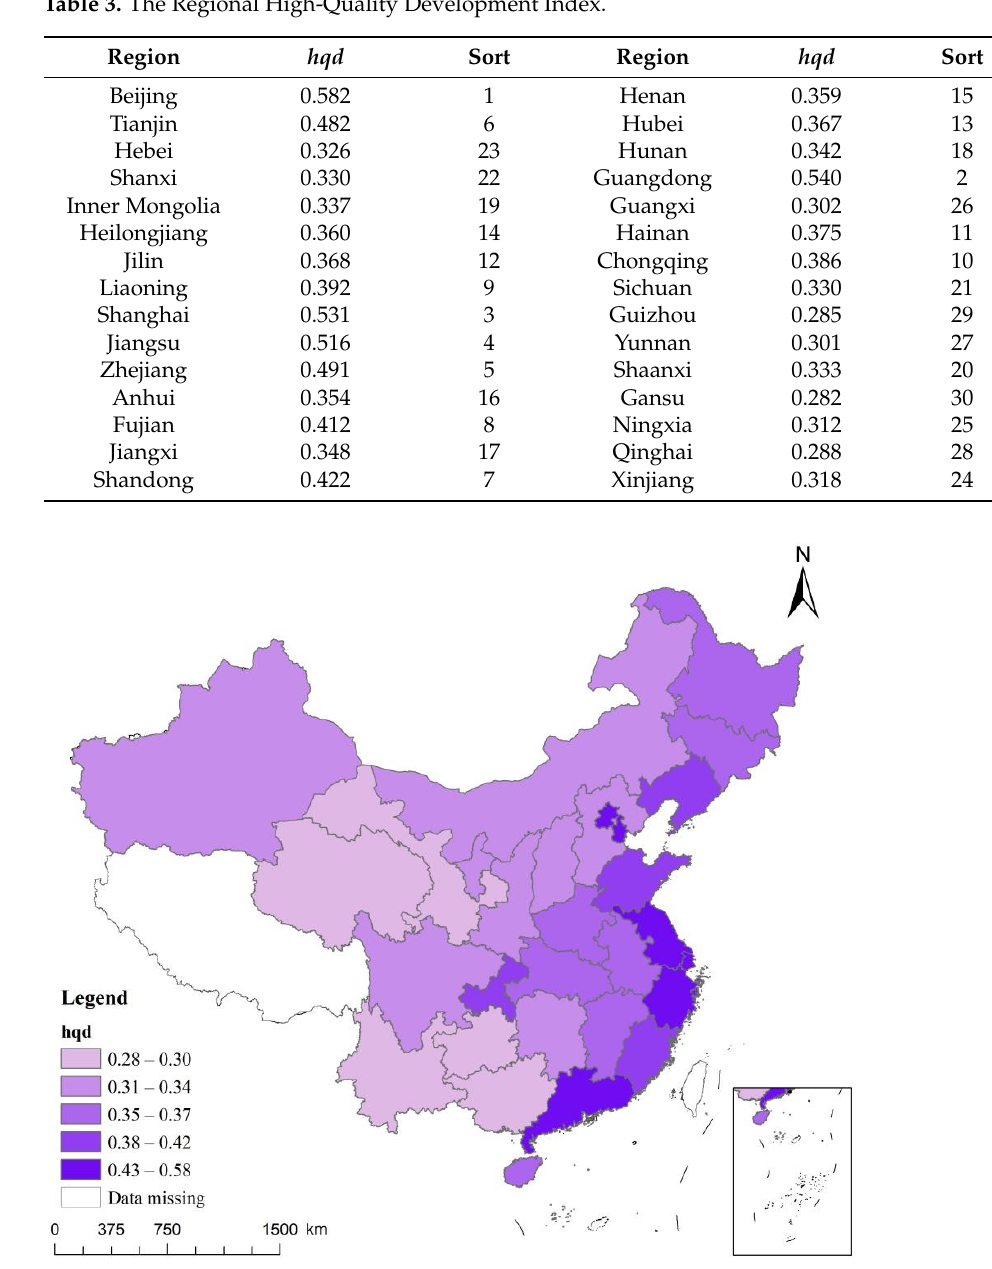
Figure 1. Average Ranking of Sustainable Development of Chinese provinces (Drawing Review No. GS(2019)1822), http://bzdt.ch.mnr.gov.cn/download.html?searchText=GS(2019)1822 (accessed on 8 August 2022). Table 3. The Regional High-Quality Development Index.